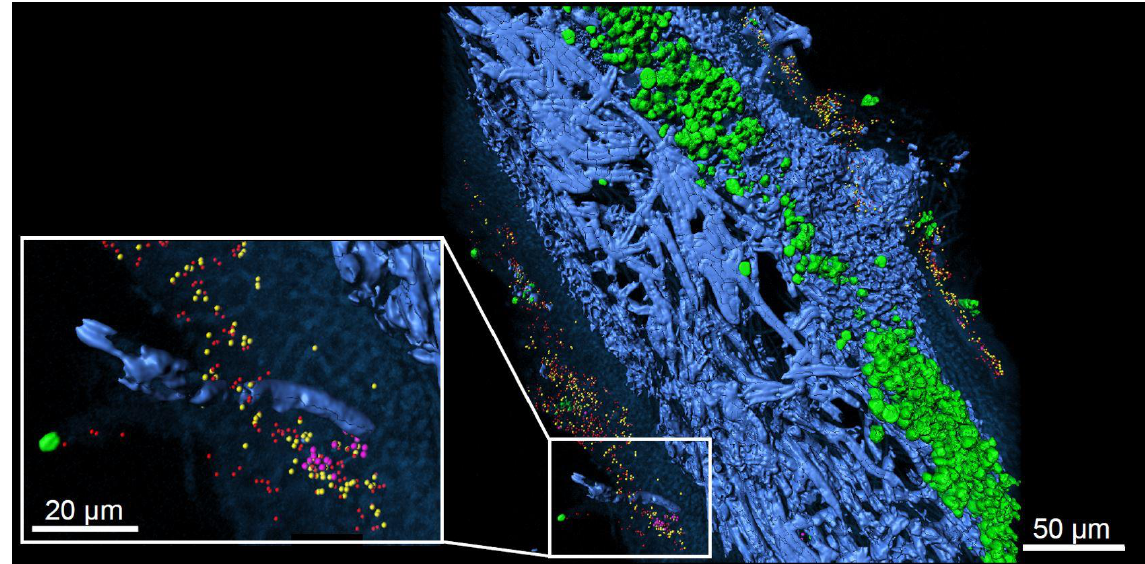
FIGURE 2: Lichen thallus structure of lung lichen Lobaria pulmonaria in cross-section. 3D reconstruction of FISH image stacks. Eubacteria (red) and Alphaproteobacteria (yellow) were found widespread on both, the upper and the lower cortex, while Betaproteobacteria (pink) were less abundant and locally contained. Fungal hyphae (blue) and algae located under the upper cortex (green) are visualized by their autofluorescence (from [10] with permission of Springer